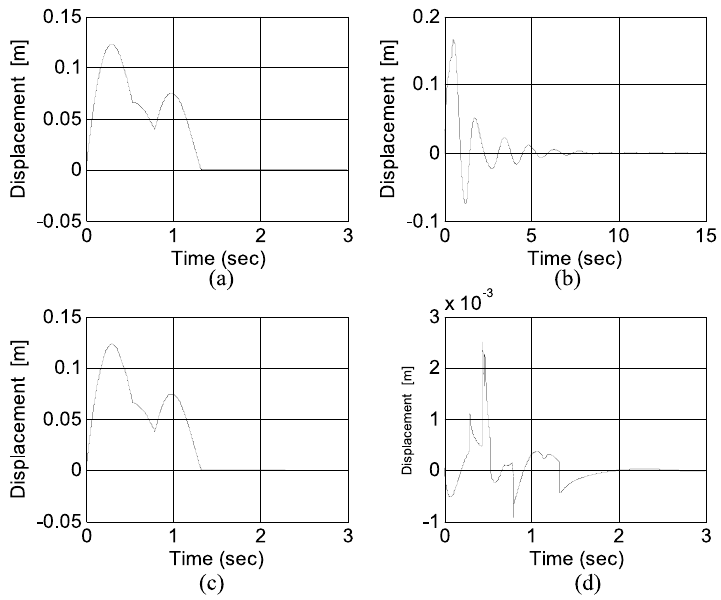
Fig.4. (a) Response with exact cancellation (b)Response with inaccurate impulse application instance [18] (c) Response with parameter variations and external disturbance (d) Output error. rad/s, ζ 1 o = 0 . 2 , ω 2 o = 3 rad/s and ζ 2 o = 0 . 1 respectively, which the natural frequency and damping ratio